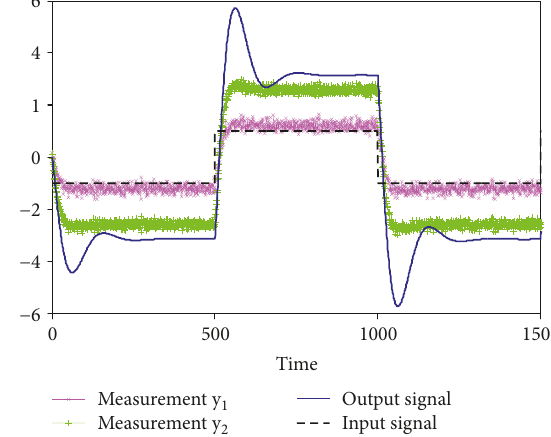
Figure 6: The estimation of x ( L =200).